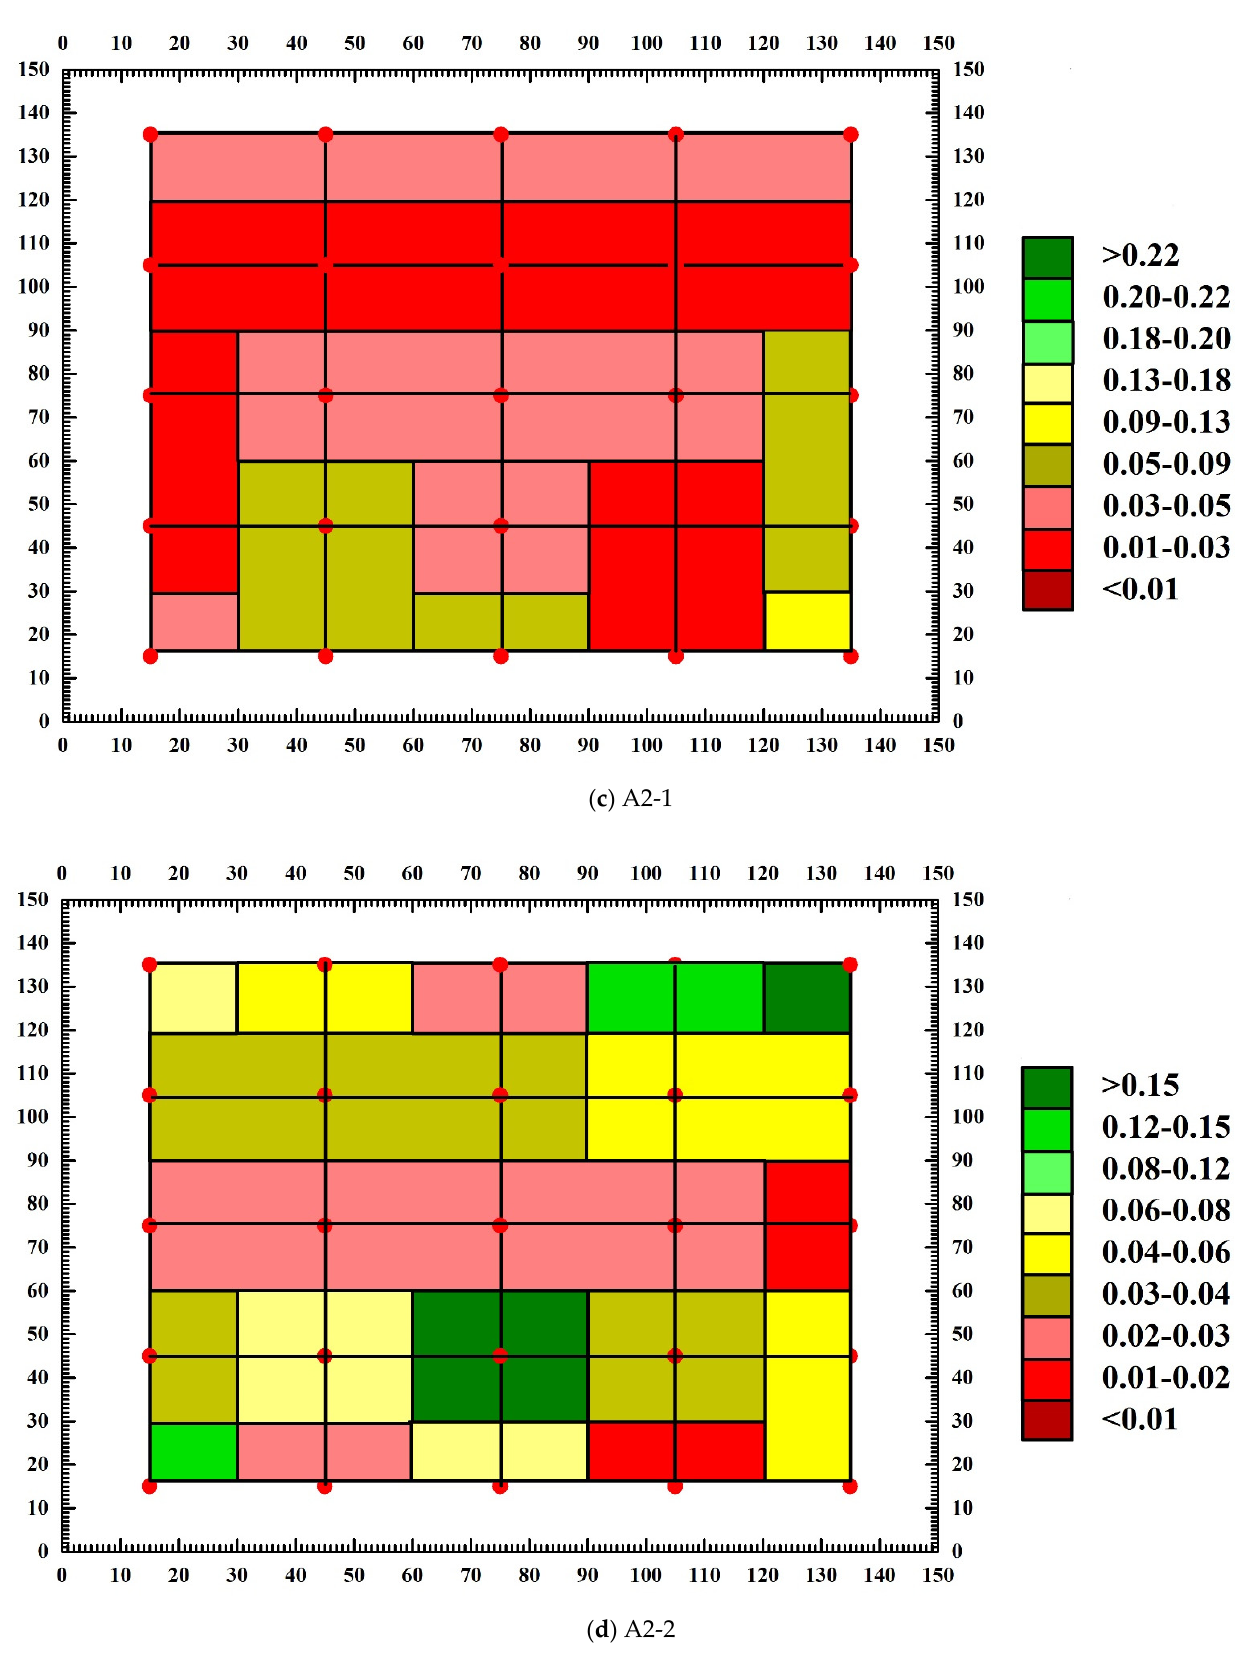
Figure 13. Sound velocity chromatogram before test block destruction.